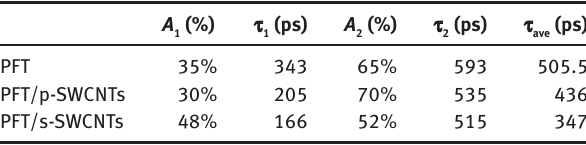
Table 2: Two-exponential fitting for the time-resolved PLE spectra of the PFT in different solutions at 505 nm emission wavelength when excited at 430